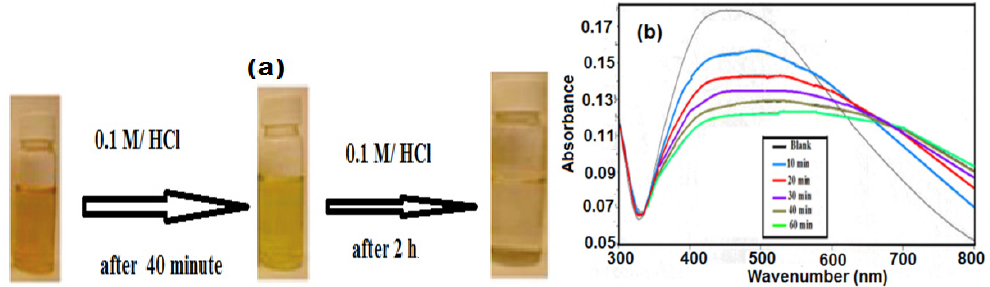
Figure 4. Citrate Ag NPs ( a ) digital photo ( b ) their UV-Vis absorption spectra at timed intervals in 0.1 M HCl.